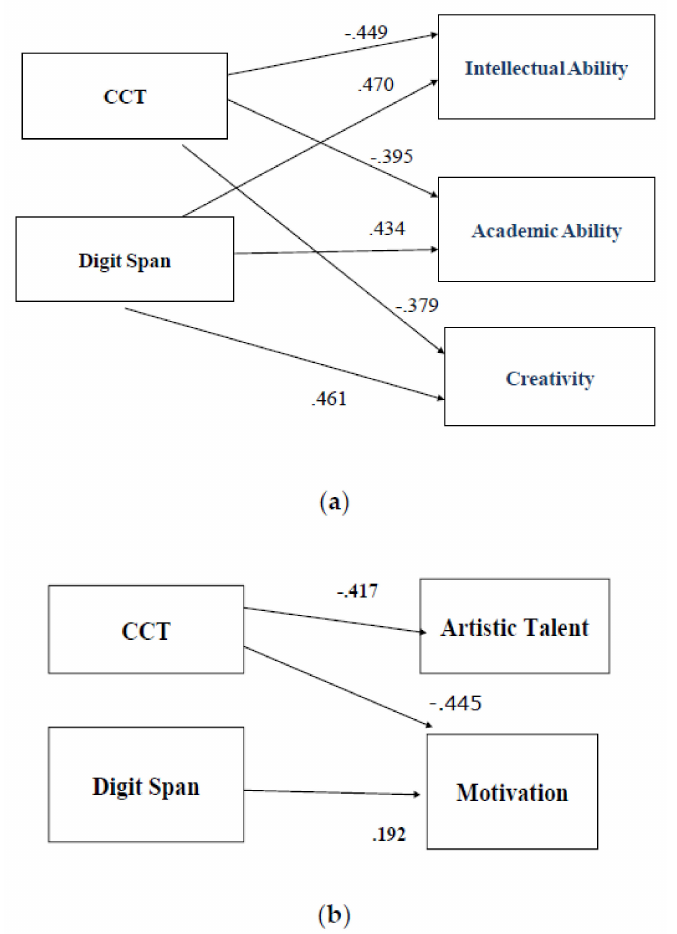
Figure 2. ( a ) The relations of the children’s category test and the digit span subtest to the intellectual, academic, and creativity GRS-P scales. ( b ) The relations of the children’s category test and the digit span subtest to the artistic talent and motivation